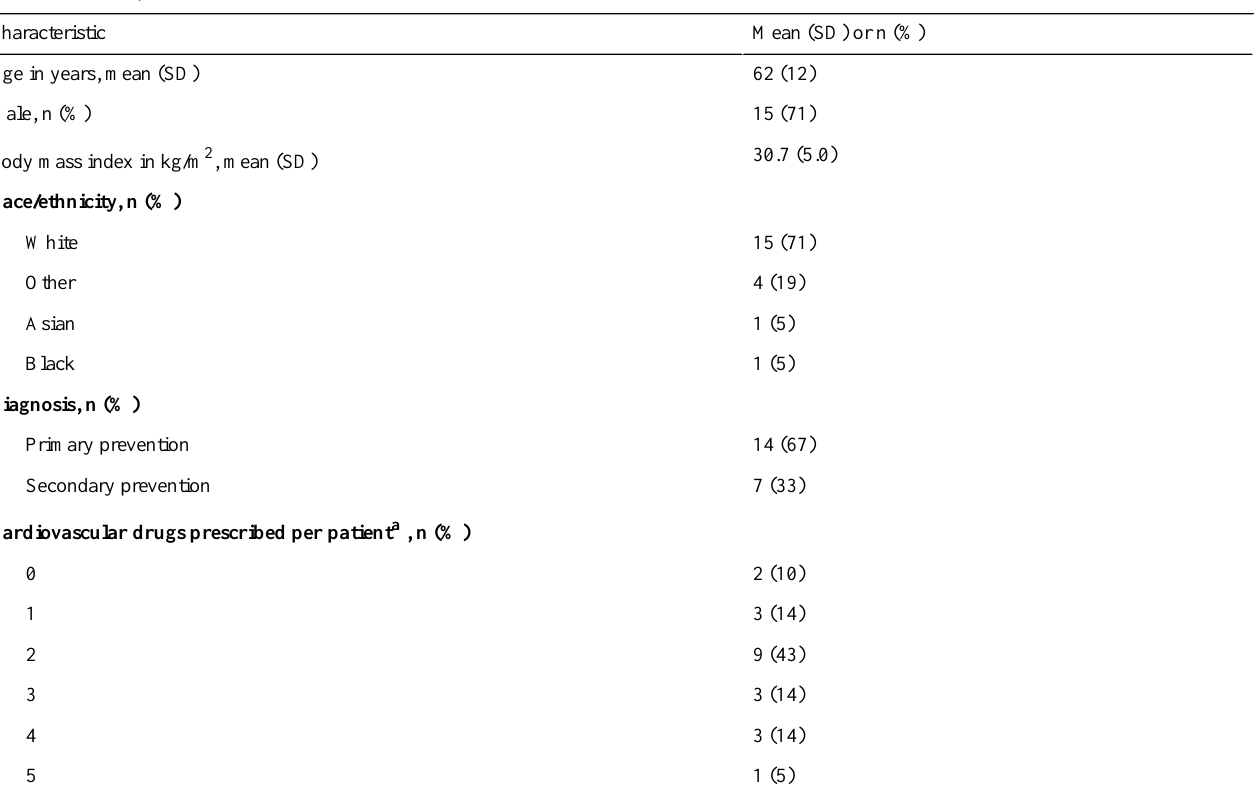
Table 1. Baseline patient characteristics (n=21).